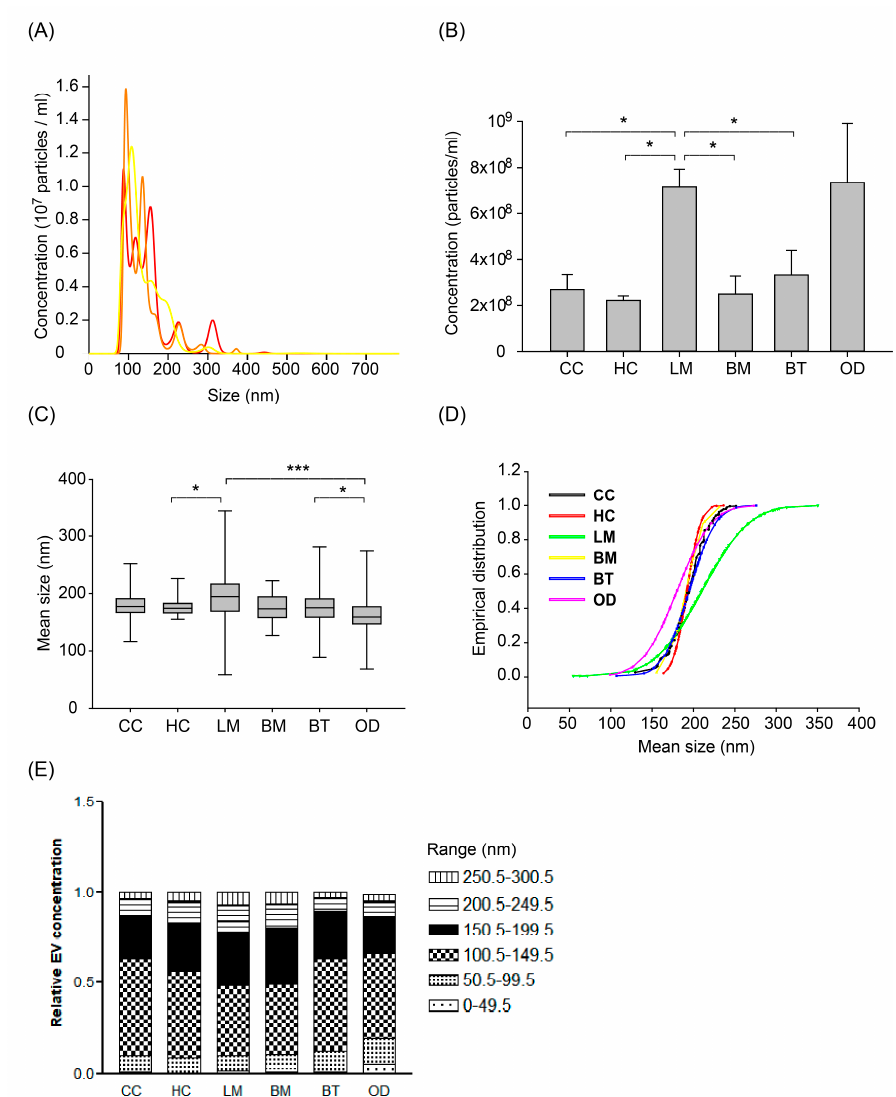
Figure 2. The number of extracellular vesicles (EVs) measured by Nanoparticle Tracking Analysis using the Nanosight NS300 system according to patients groups. ( A ) Representative image of NTA measurement (repeated 3 times per one sample and an average value was provided). ( B ) Extracellular vesicle (EV) concentration according to patient groups. Different EV concentrations among groups of ‘Other disease’ according to different disease of multiple sclerosis, intracranial hemorrhage, and central nervous system (CNS) infection (see details in Supplementary Figure S5) (ANOVA, Dunn’s multiple comparison, * p < 0.05). ( C ) Box plot of size distribution of EVs according to patient groups. The thick bar represents the mean value, and the box denotes the quartile range. (ANOVA, Dunn’s multiple comparison, * p < 0.05, *** p < 0.001) ( D ) Empirical cumulative distribution plot of mean size of extracellular vesicles. (The empirical cumulative distribution function (ECDF) was generated by the Ecdf function in R, Kolmogorov-Smirnov tests were performed to compare the significance between groups) ( E ) The proportion of EV size by tentative size interval of 50 nm (0–300 nm). Abbreviations: CC, cancer control; HC, healthy control; LM, leptomeningeal metastasis; BM, brain metastasis; BT, brain tumor.